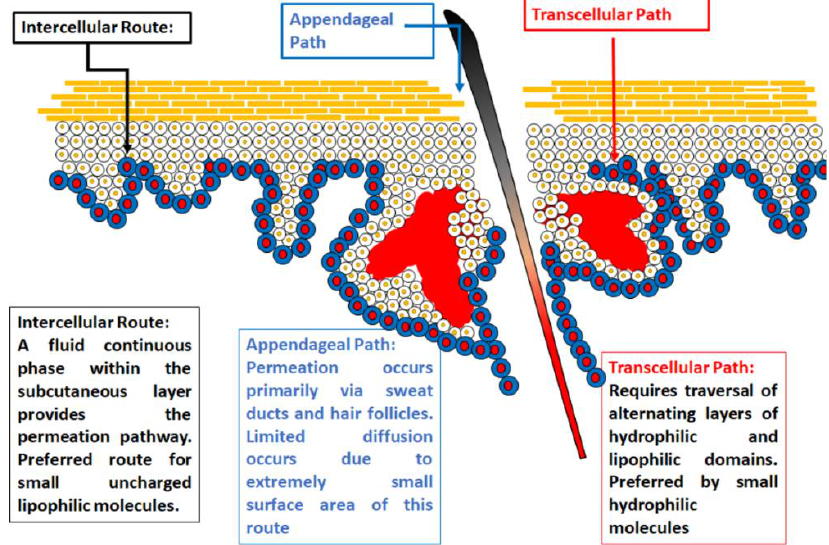
Figure 5. Depiction of the possible routes of transdermal permeation which lead to effective transdermal absorption.